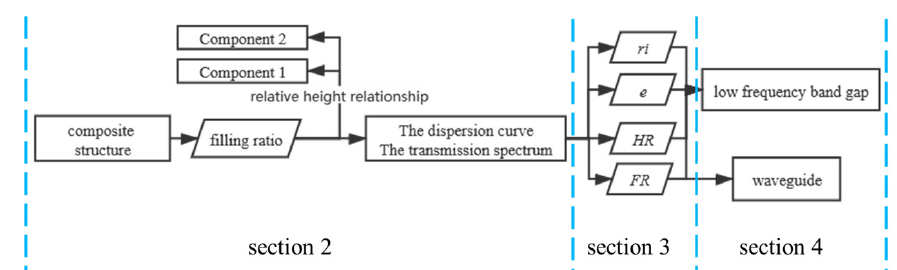
Figure 1. Diagram of the research idea.